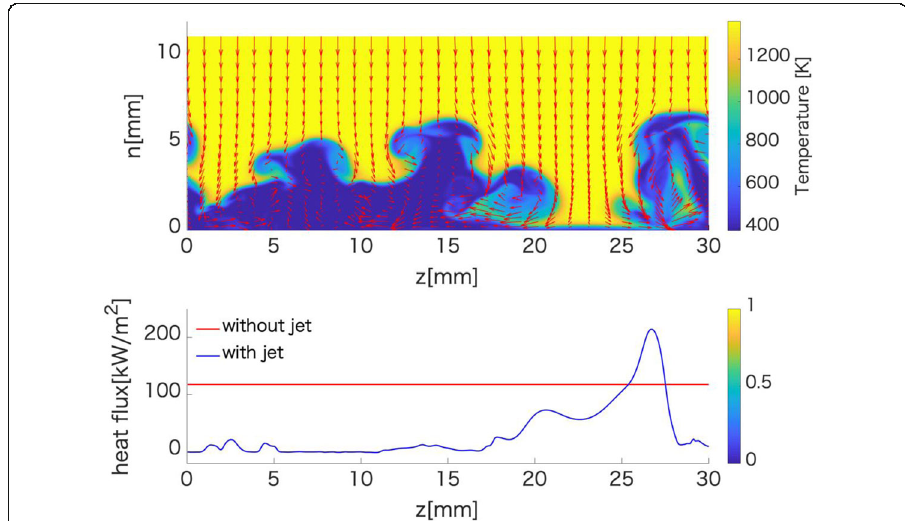
Fig. 7 A snapshot of the temperature field in the transverse cross section θ = − 15 [ deg ] (Point A). The projections of the velocity vectors on to the plane and the heat flux distribution over the cylinder surface are also